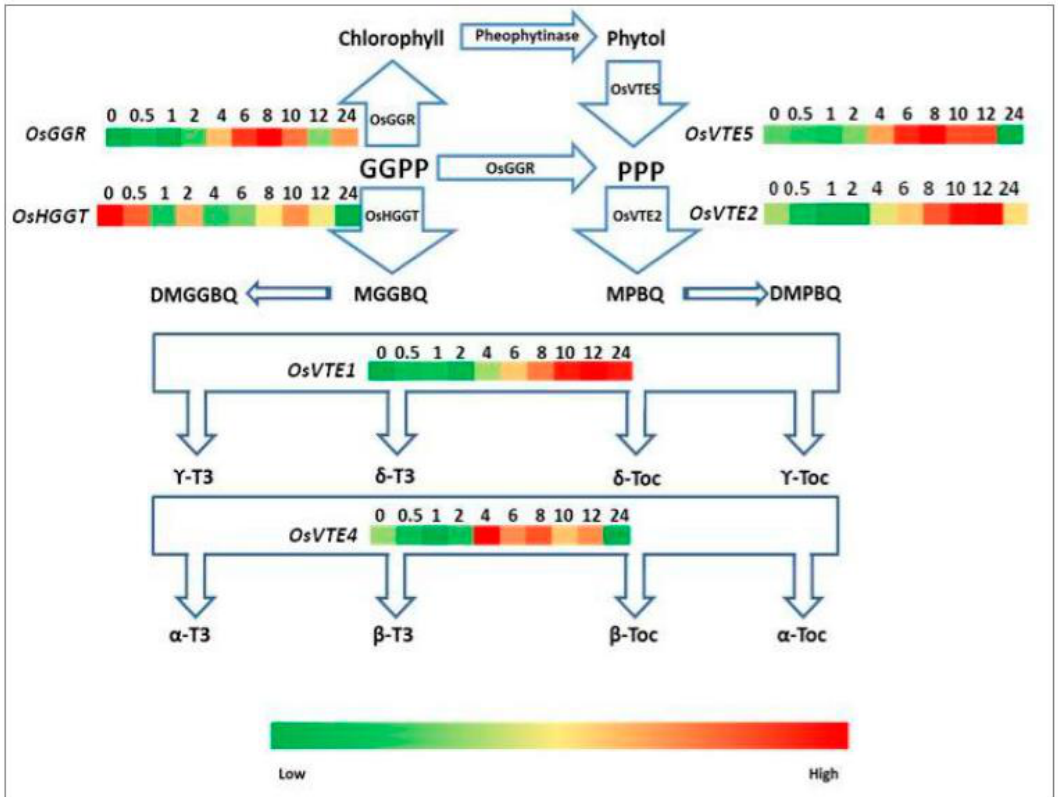
Figure 5. Relative expression levels of tocopherol pathway genes in etiolated leaves during de-etiolation at different times after the onset of irradiation with white light. Abbreviations: DMGGBQ, 2,3-dimethyl-6-geranylgeranylbenzoquinol; DMPBQ, 2,3-dimethyl-6-phytylbenzoquinol; MGGBQ, 2-methyl-6-geranylgeranylbenzoquinol; MPBQ, 2-methyl-6-phytylbenzoquinol; OsGGR , geranylgeranyl reductase gene; OsHGGT , rice homogentisate geranylgeranyltransferase gene; OsVTE1 , tocopherol cyclase gene; OsVTE2 , homogentisate phytyltransferase gene; OsVTE4 , γ -tocopherol methyltransferase gene; OsVTE5 , phytol kinase gene; PPP, phytyl pyrophosphate; α -Toc, α -Tocopherol; β -Toc, β -Tocopherol; γ -Toc, γ -Tocopherol; δ -Toc, δ -Tocopherol; α -T3, α -Tocotrienol; β -T3, β -Tocotrienol; γ -T3, γ -Tocotrienol; δ -T3, δ